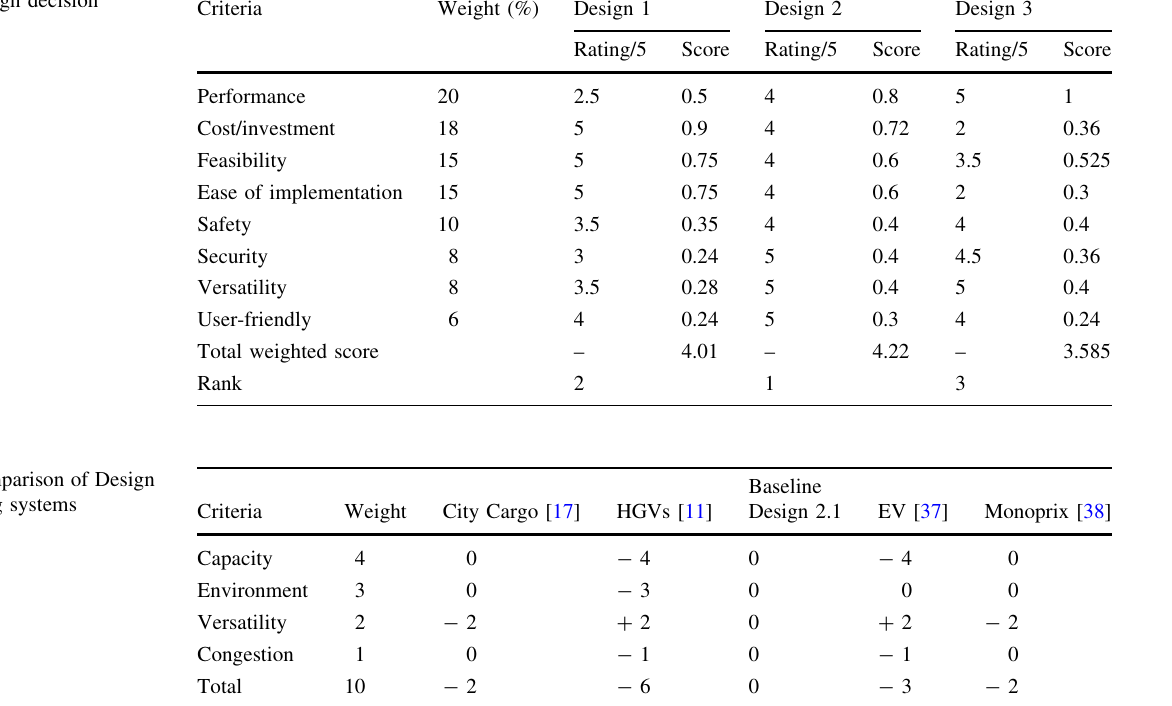
Table 1 Design decision